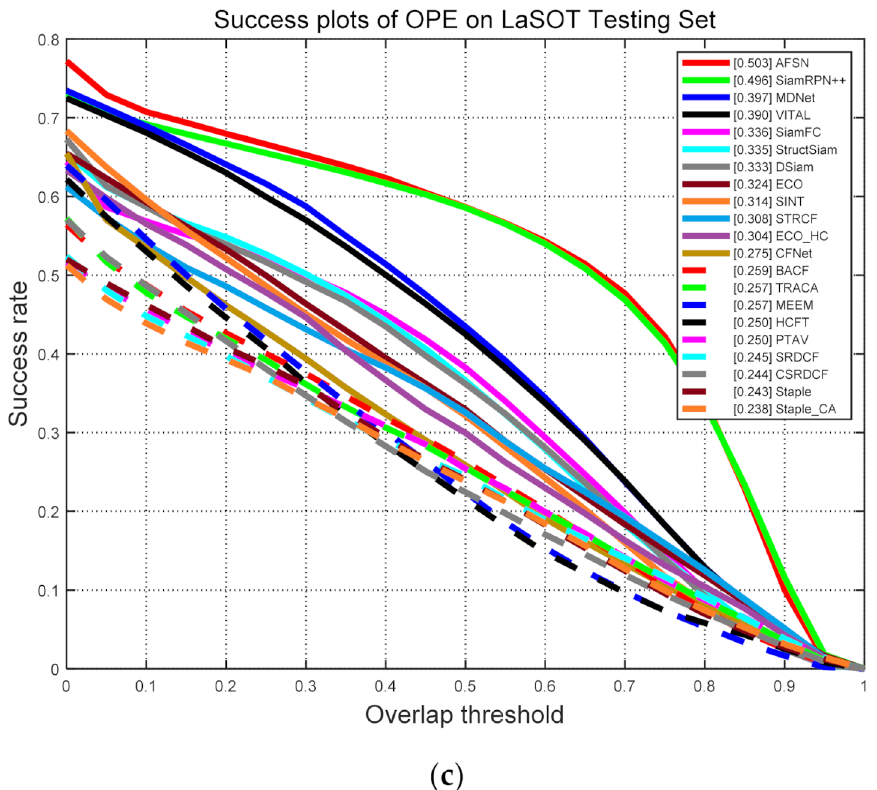
Figure 5. Comparisons among top 20 trackers on LaSOT. ( a ) Normalized precision plots, ( b ) precision plots, and ( c ) success plots. Our AFSN significantly outperforms other methods in precision and suc-